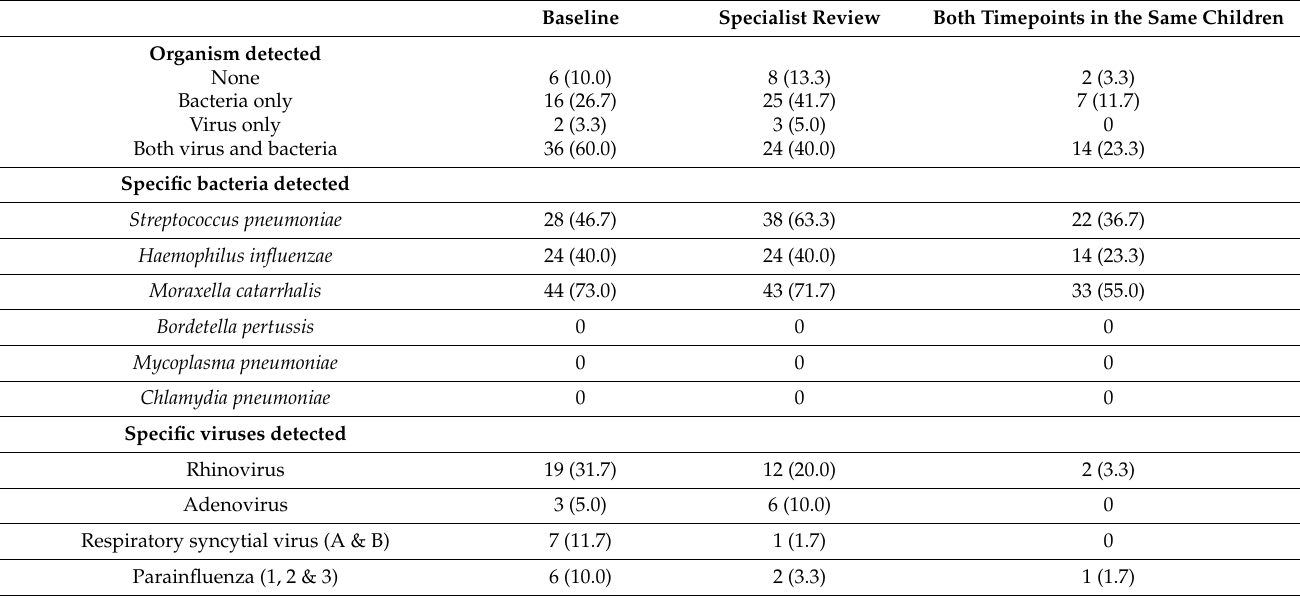
Table 4. Nasal microbiology in children with PBB at baseline, at time of specialist review, and who were positive at both time points ( N = 60 children with specimens at both time